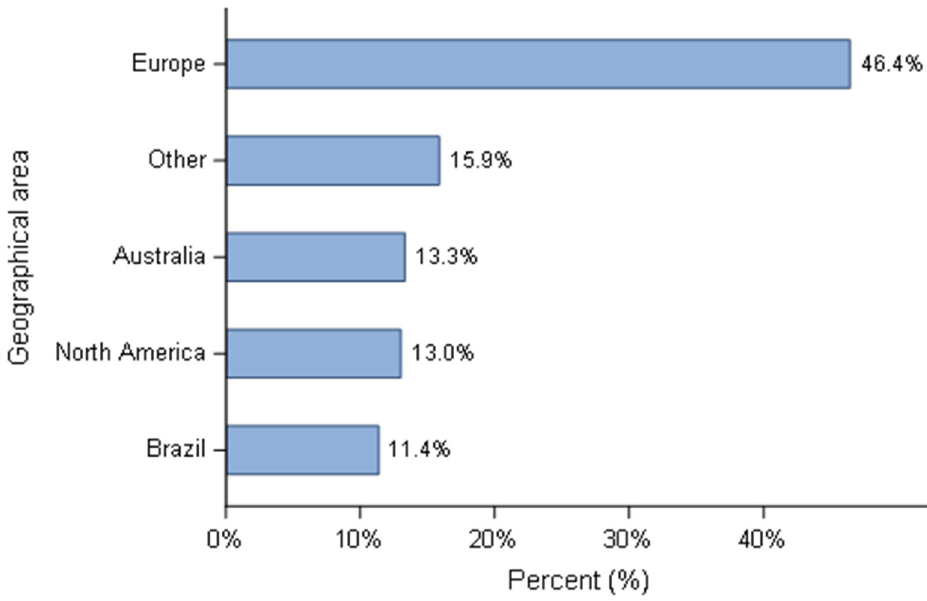
Figure 2. Responders’ distribution grouped by geographical region—all responders ( n = 668).